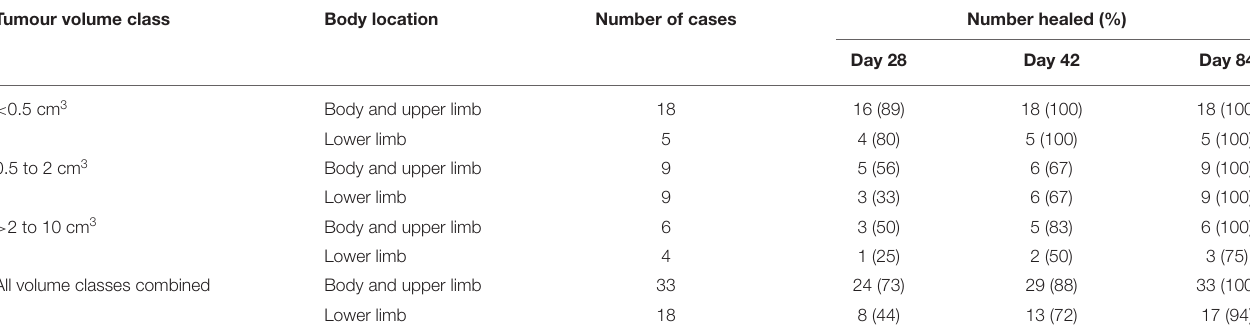
TABLE 1 | Number and percentage of healed tissue deficits for the 51 cases recurrence free at 12 months that received a single tigilanol tiglate (TT) treatment according to body location and tumour volume class when assessed during the US pivotal study on 28, 42, and 84 days post treatment. Tumour volume